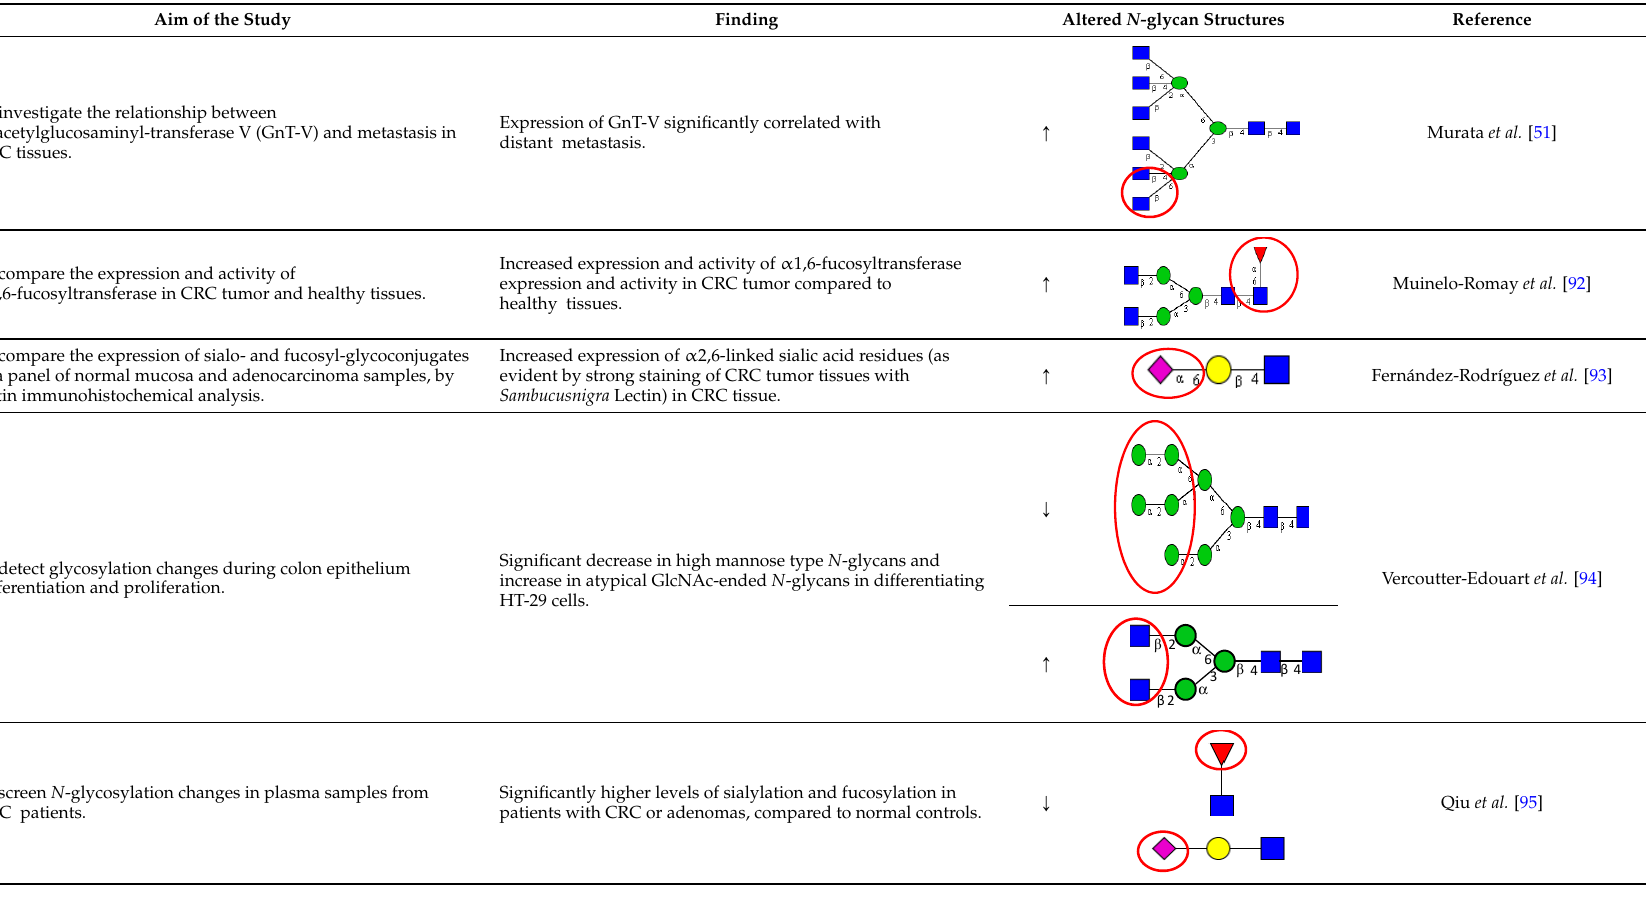
markers for prediction and detection of